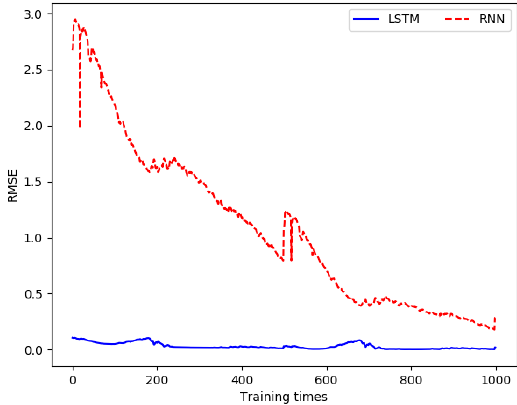
Figure 16. Comparison of RMSE for water temperature.